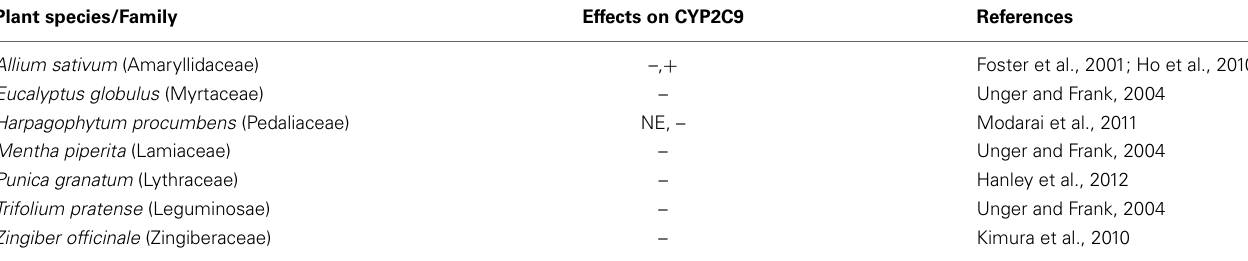
Table 2 | Medicinal plant species listed in RENISUS with reported effects of on CYP2C9. Plant